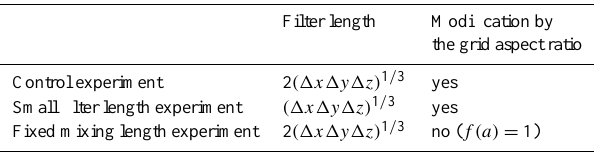
Table 2. Filter lengths and the effect of grid aspect ratio on mixing length in the three experiments performed in this study.